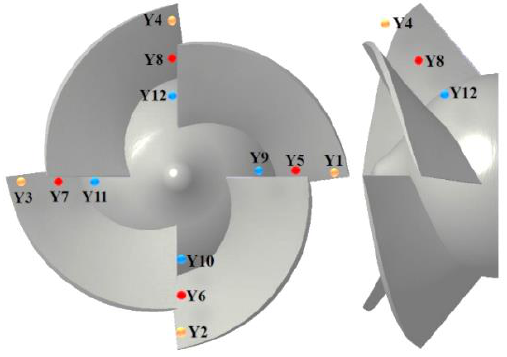
Figure 20. Position of impeller outlet monitoring